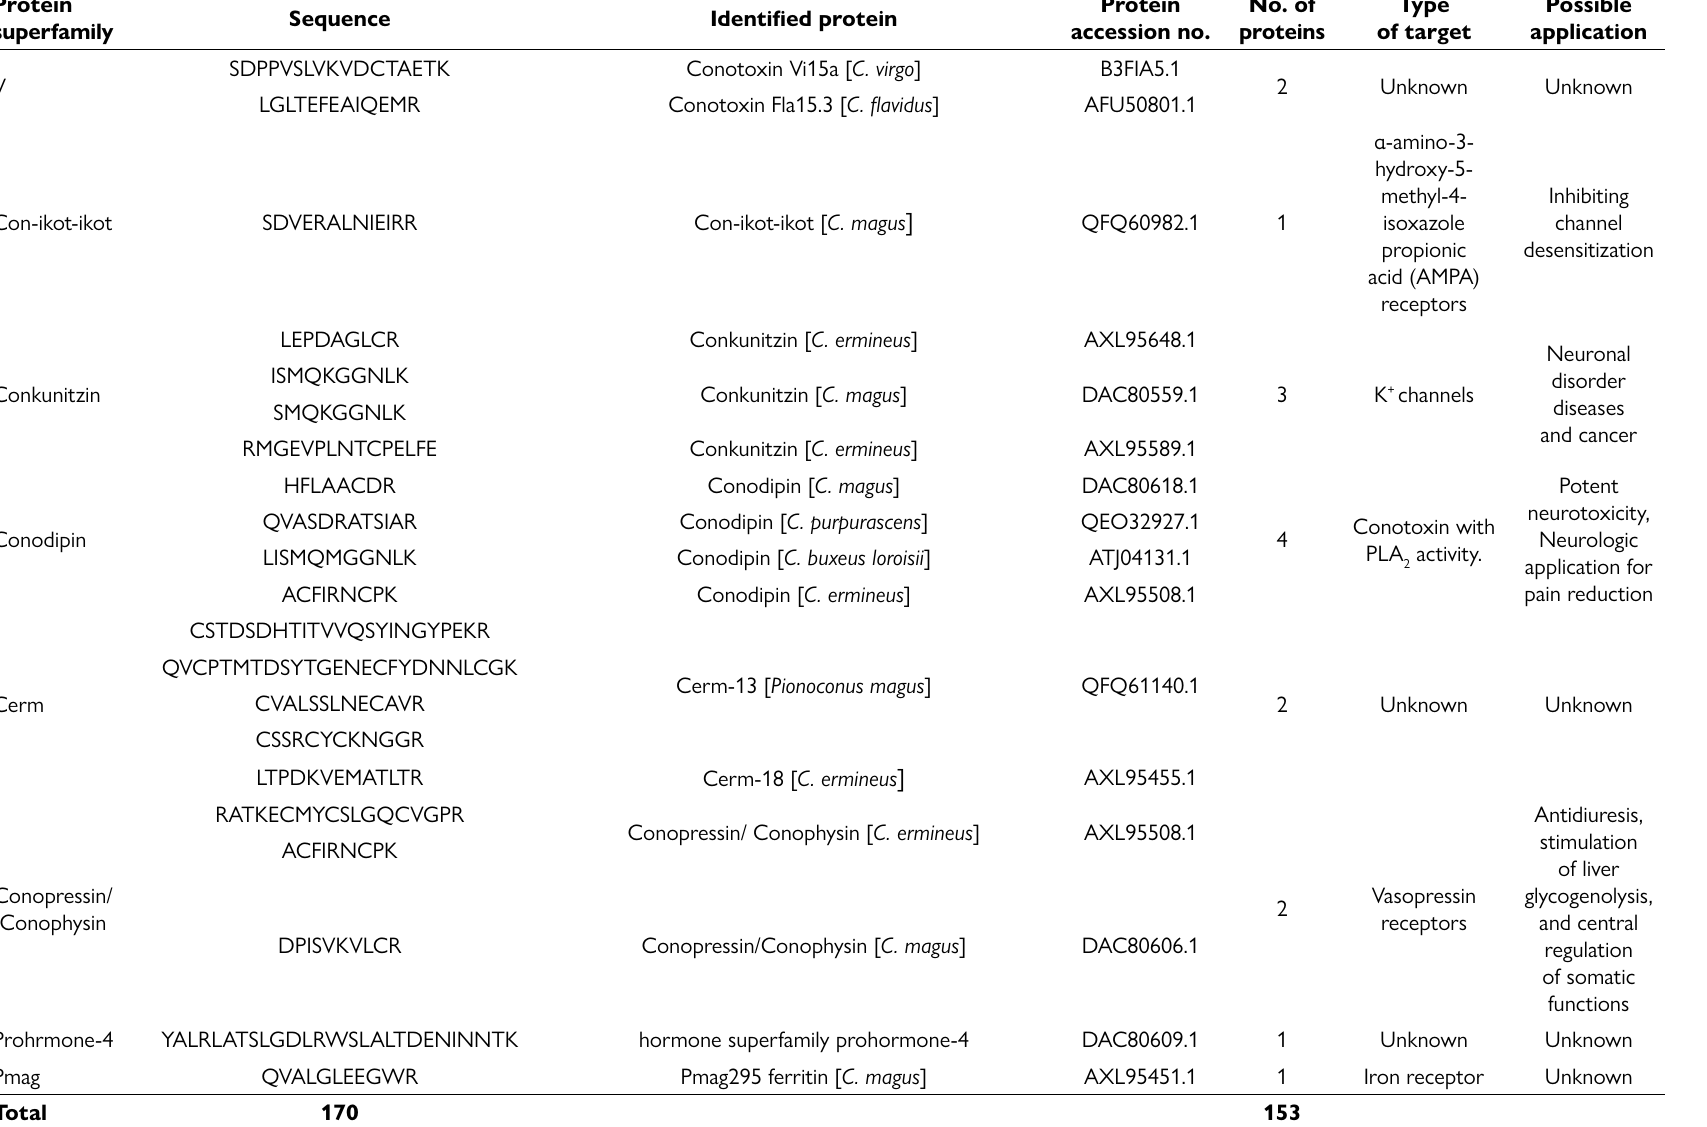
Table 1. Protein